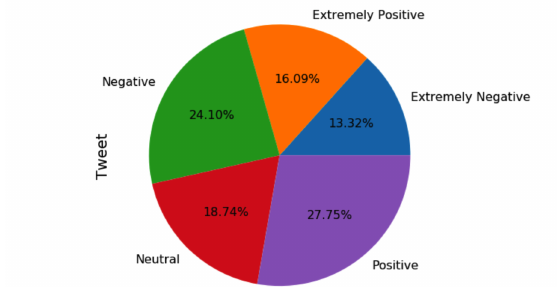
Figure 1. Class distribution of the training